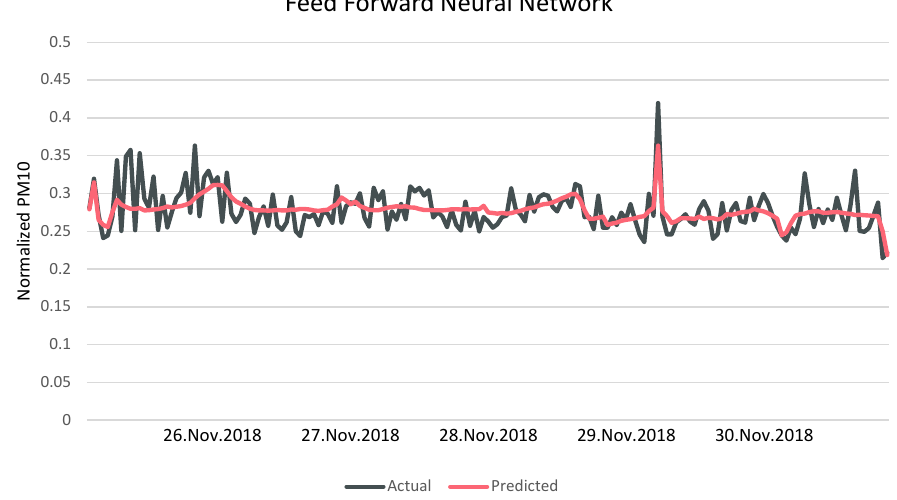
Figure 10. Comparison between the Feedforward Neural Network prediction (FFNN) and the test data.